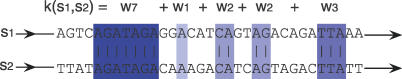
Given Two Sequences, s
1 and s
2 of Equal Length, Our Kernel Consists of a Weighted Sum to Which Each Match in the Sequences Makes a Contribution w
l Depending on Its Length l, Where Longer Matches Contribute More SignificantlyFor predictions, we use a window of 140 nt around the potential splice site (cf. Materials and Methods for details, including the procedure of how the length of the window is determined).